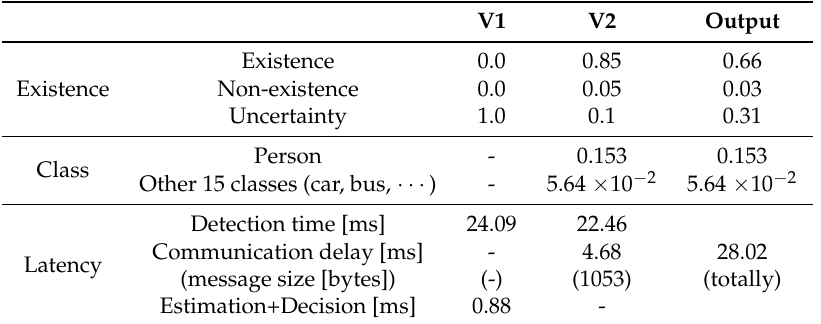
Table 3. Experimental results for the anti-collision case.